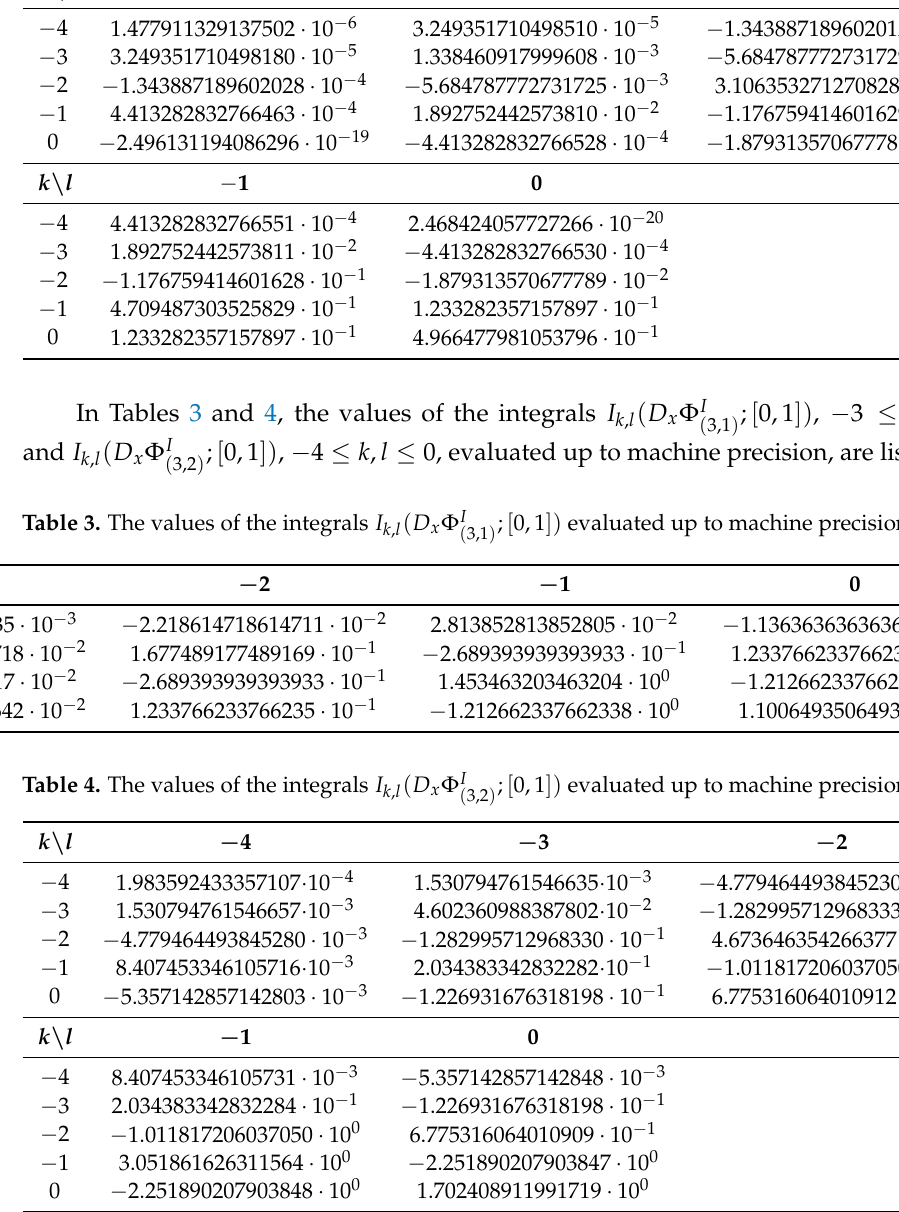
Table 1. The values of the integrals I k , l ( Φ I